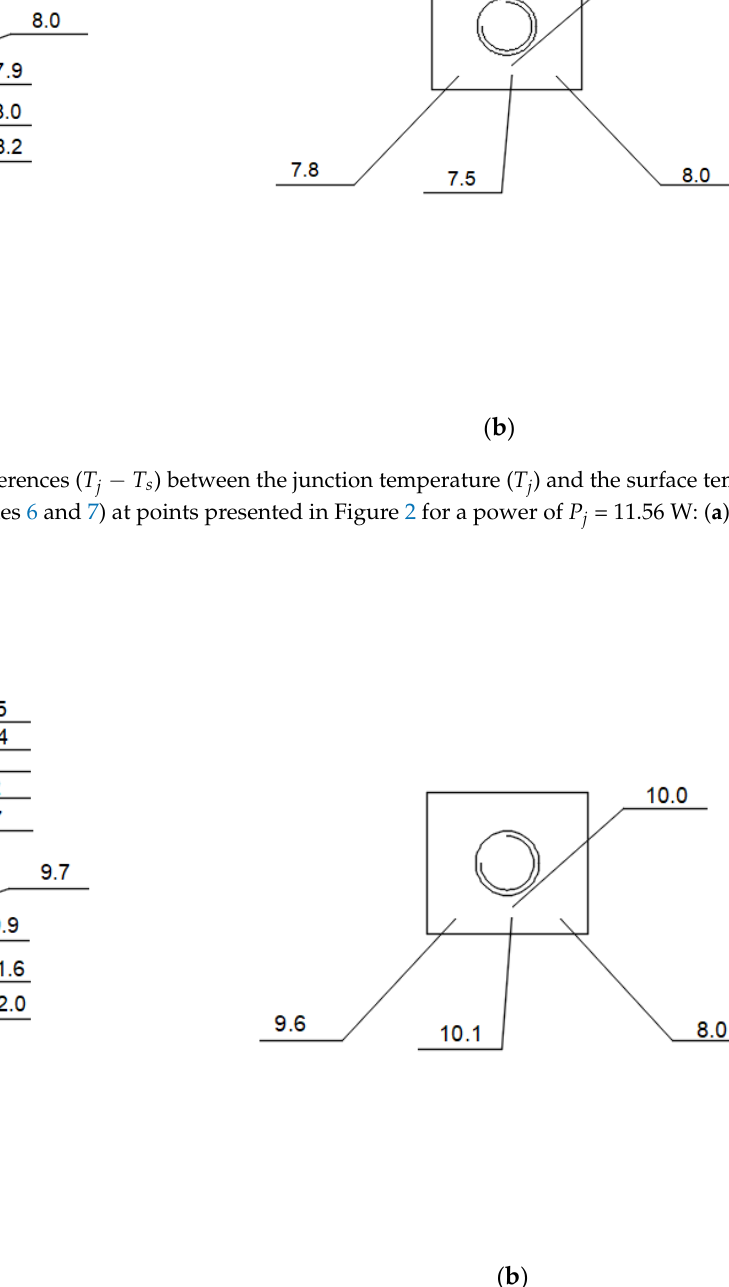
( b ) Figure 19. Differences ( T j – T s ) between the junction temperature ( T j ) and the surface temperatures ( T S ) (from Tables 6 and 7) at points presented in Figure 2 for a power of Pj = 49.61 W: ( a ) side view; ( b ) top view.